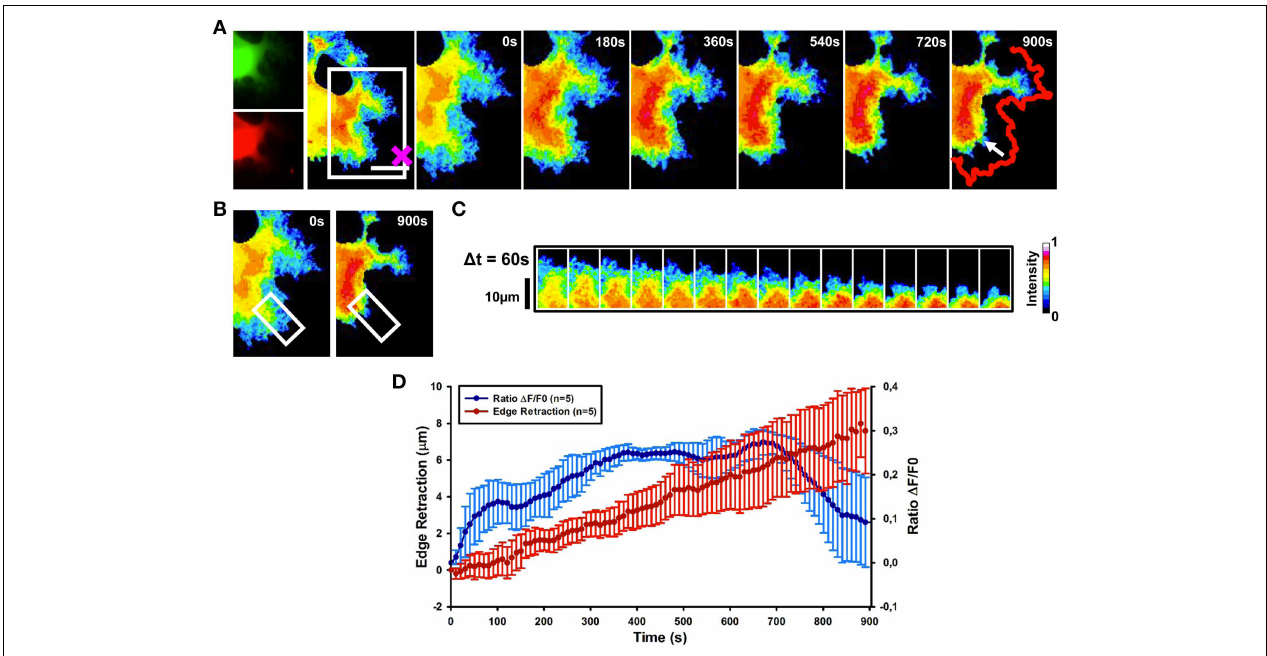
FIGURE 5 | RhoA activation dynamics upon local release of Sema3A. (A) Ratiometric FRET live imaging of a representative RhoA-FRET neuroblastoma cell upon Sema3A stimulation. Frames were taken every second (left: generation of a ratiometric image) for 15min (the cross indicates the position of the lipid vesicle filled with Sema3A). Insets on the right show a time series (1 frame every 3min) of the magnified region denoted by the white box in the left image. Arrow indicates the retraction direction. The red line shows the initial edge profile. Scale Bar: 20 µ m. (B,C) Montage images